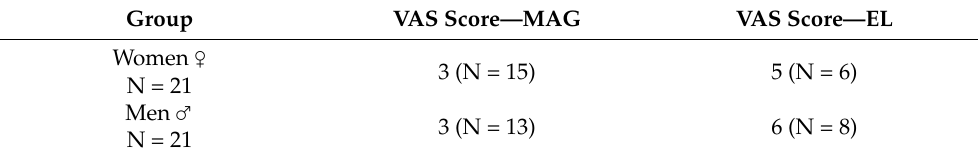
Table 6. Results of mean values for 10-point visual analog pain scale (VAS) reported by women and men. Group VAS Score—MAG